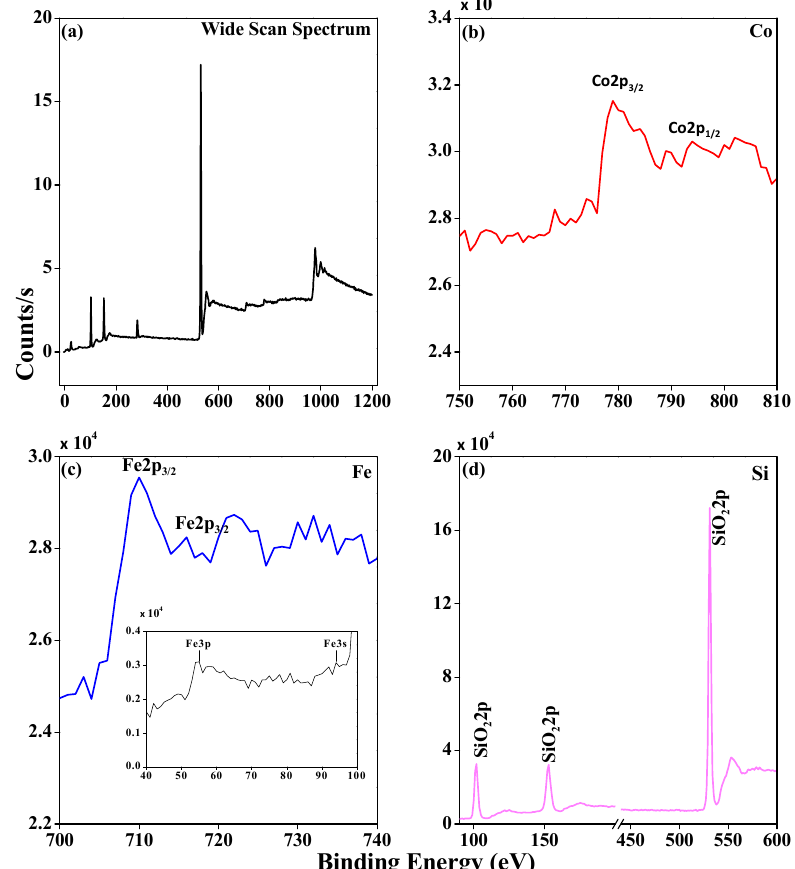
Fig. 4. XPS spectra for (a) CoFe Figure 4: XPS spectra for (a) CoFe 2 O 4 @SiO 2 system (b) Co (c) Fe (d) Si elements